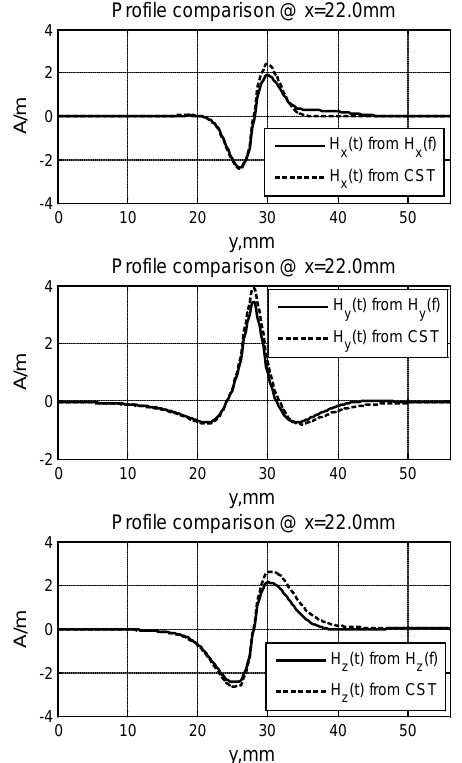
Figure 11: C omparisons of t he magnetic f ield components profiles obt ained f rom t he pr oposed tim e-frequency computation method and the direct calculation, detected in the vertical plane x =